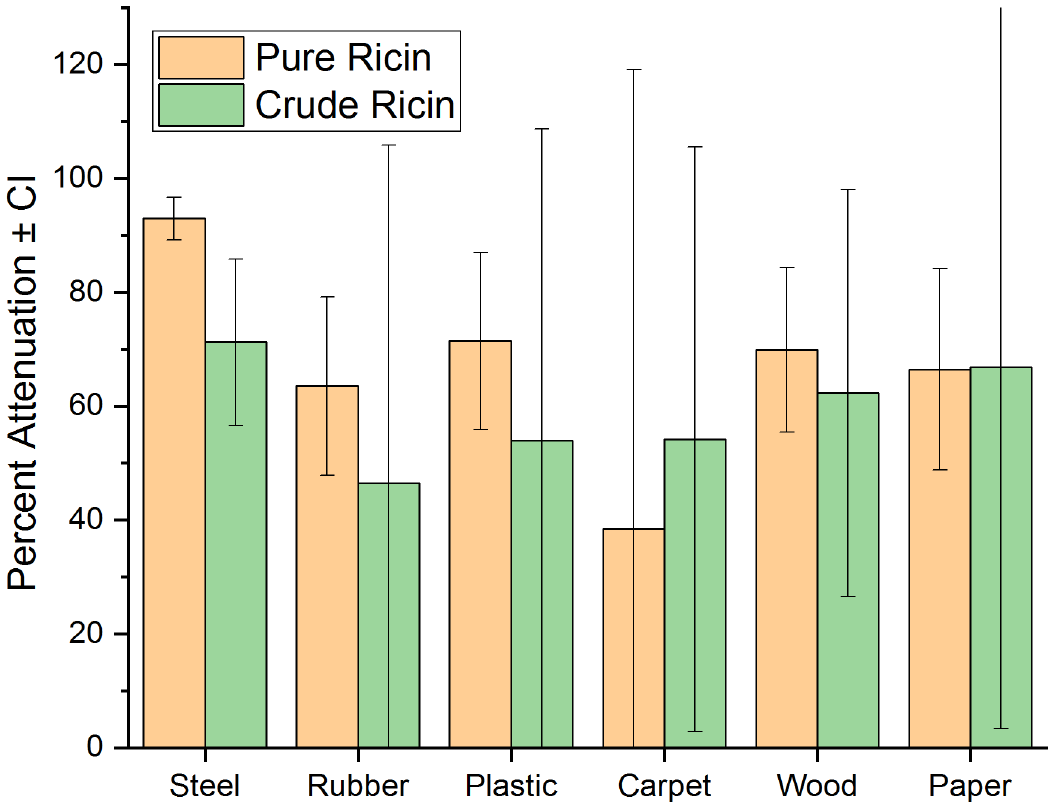
Fig 1. Average percent reduction for pure ricin and crude ricin by material ± standard deviation, for tests 1–14 (20–30˚C).